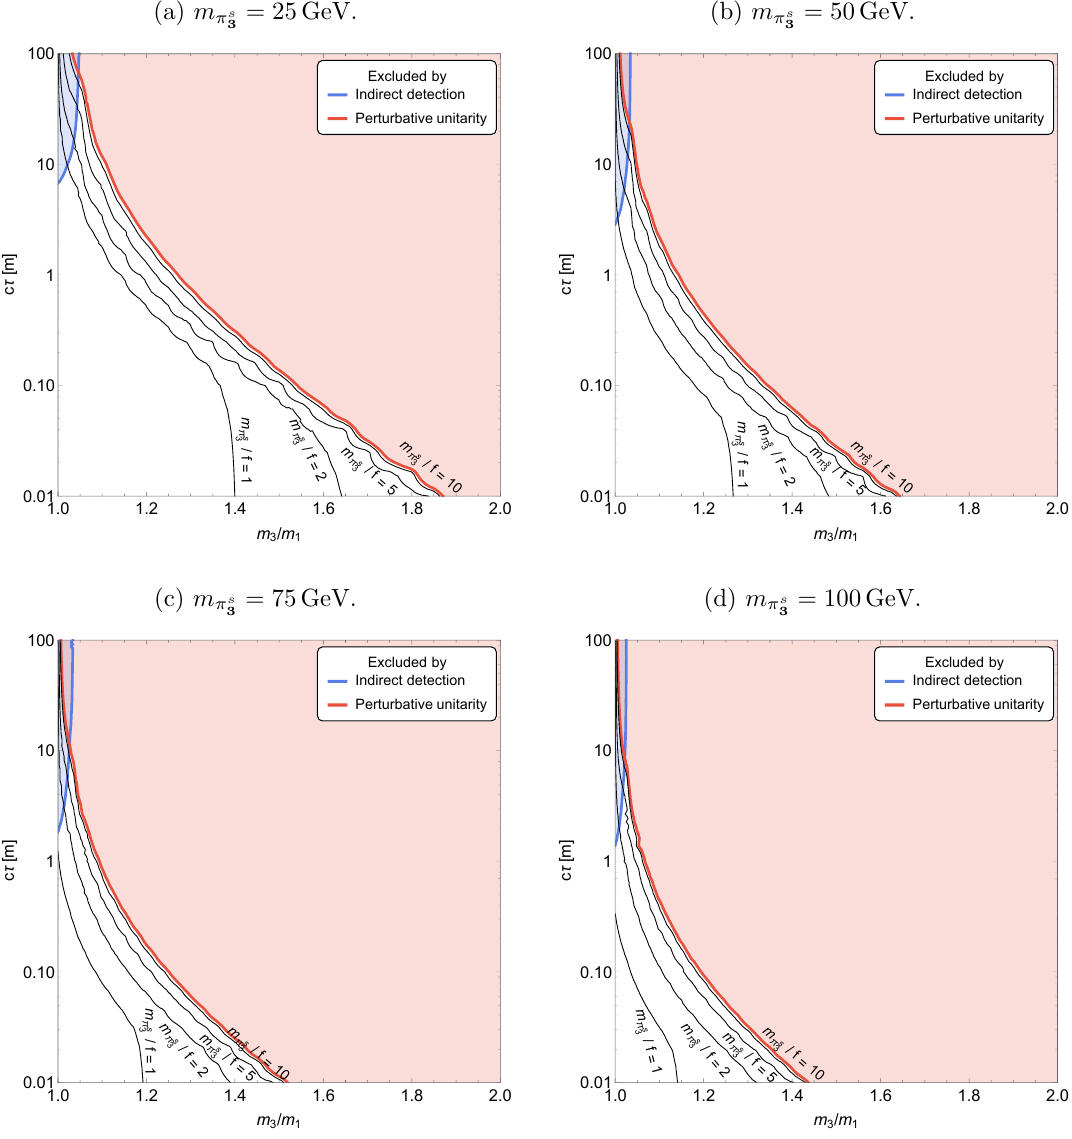
Figure 6. Allowed region of parameter space for the benchmark CIIb for di(cid:11)erent masses of the triplet. The black contour lines represent constant values of m (cid:25) s by indirect detection DM searches, while the red one by perturbative unitarity constraints.